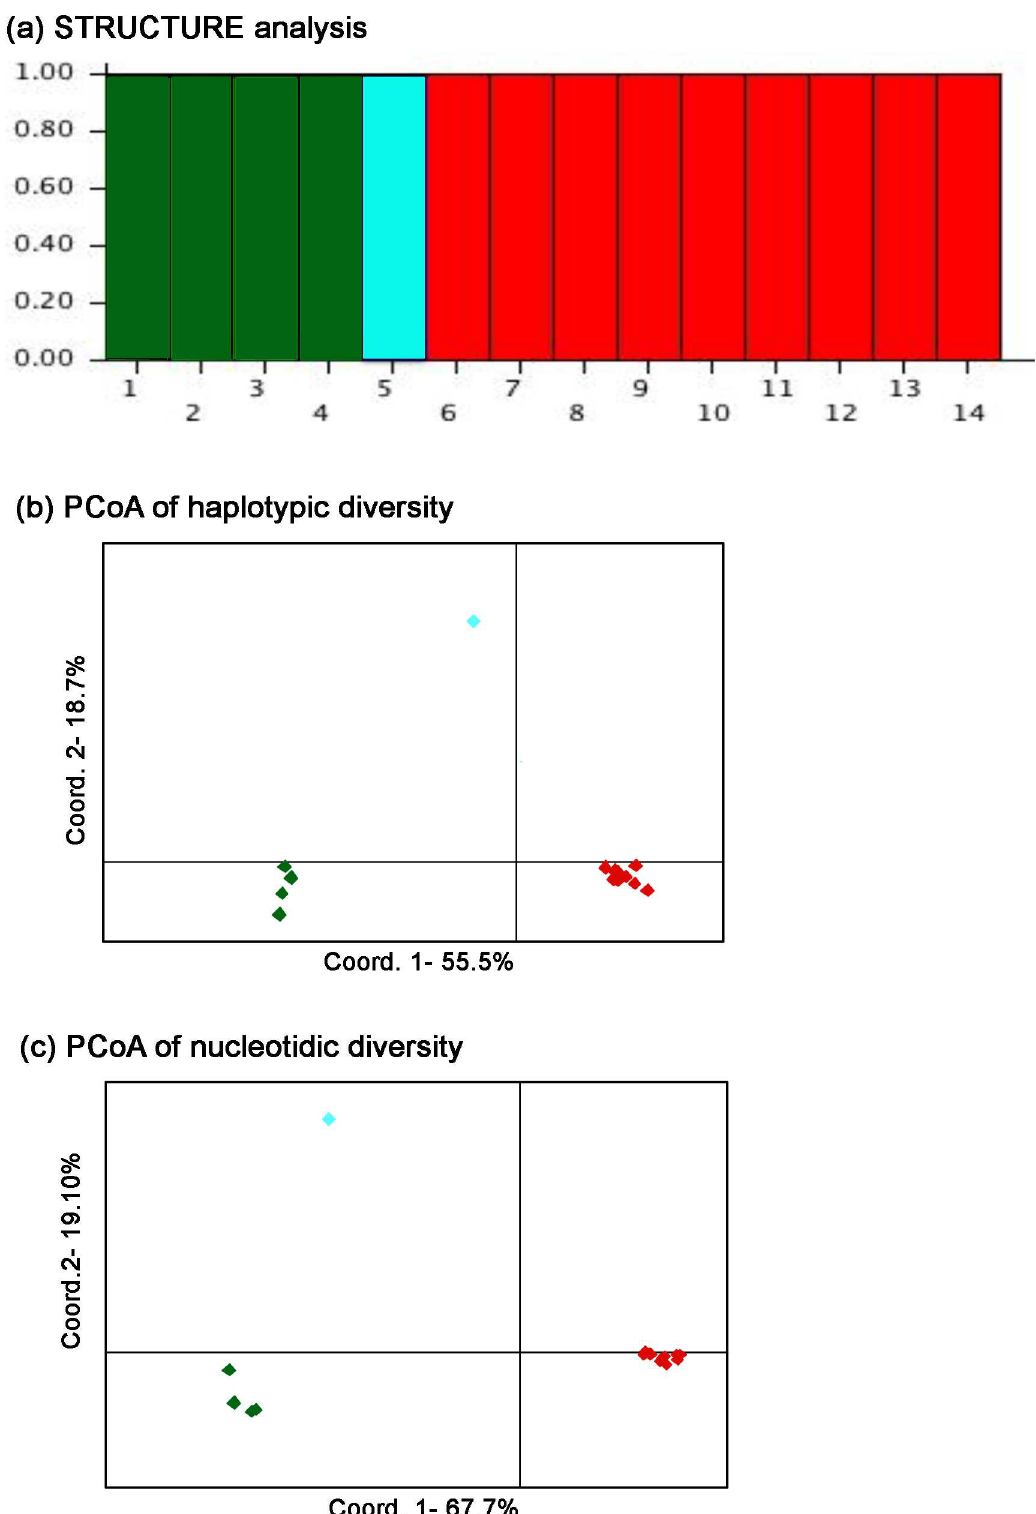
Fig 2. Analysis of population structure. Genetic clusters obtainedwith the software STRUCTURE (a), PCoA of haplotypic diversity (b) and PCoA of nucleotidicdiversity (c). The chamois from Iberia ( parva and pyrenaica )